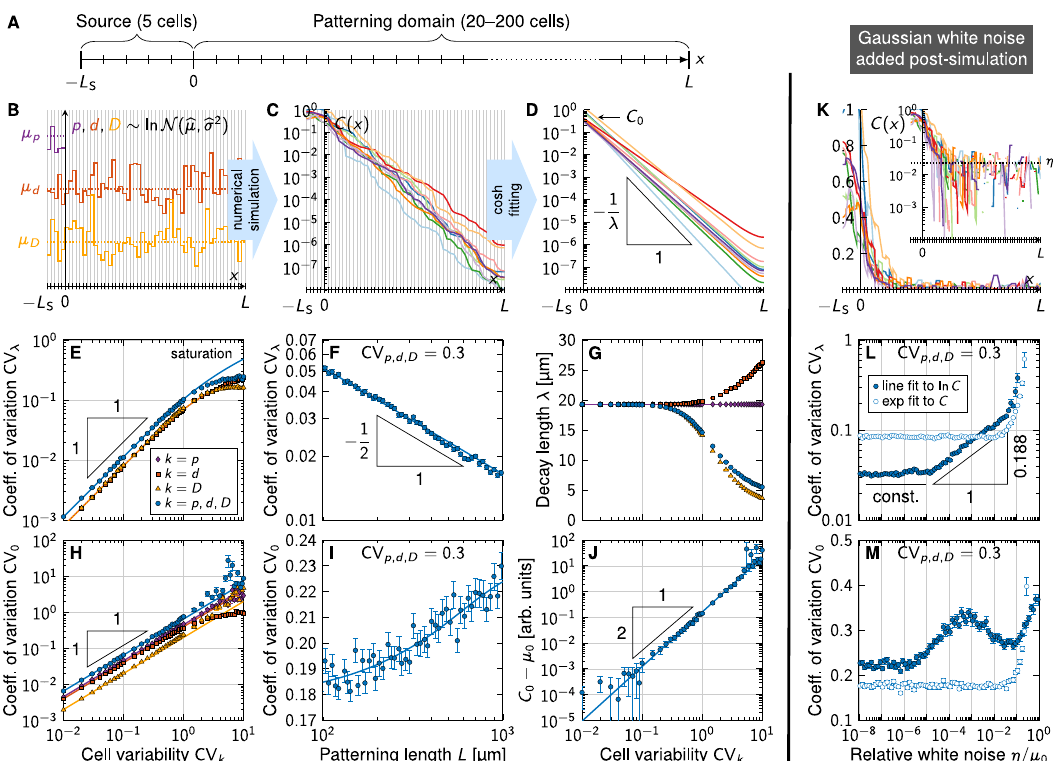
Fig. 8 Numerical model predicts gradient variability from molecular noise. A Schematic of the simulated 1D domain. B Kinetic parameters k = p , d , D (purple, red, orange) were drawn randomly and independently for each cell from log-normal distributions with speci fi ed mean μ k and coef fi cient of variation CV k . C Solving the reaction-diffusion equation repeatedly yields noisy morphogen gradients, from which the decay length λ and amplitude C 0 can be extracted by fi tting hyperbolic cosines in the patterning domain (0 ≤ x ≤ L , D ). E The resulting variability in λ grows linearly with the variability in the kinetic parameters as long as CV k ≲ 1, and saturates as CV k increases further. F The length of the domain over which noisy gradients are fi tted affects the ffiffiffi p L variability of λ according to the law of large numbers, CV λ (cid:4) 1 = . G Increasing molecular noise leads to a bias in the resulting fi tted λ . H The amplitude variability also increases linearly with CV k , but does not saturate if all three parameters have a variability exceeding one. I The variability of the fi tted amplitude moderately grows with increasing patterning domain length. J Noisy parameters also induce an overestimation of the amplitude deduced from fi tting, proportional to CV 2 N ð 0 ; η 2 Þ added to the solution in all cells limits the range over which a line can be fi tted to ln C . L Lin- k . K Gaussian white noise (cid:4) fi tting (open circles) always (also at η = 0) leads to increased decay length variability, in particular with white noise stronger than one percent of the amplitude. Log- fi tting (closed circles) is insusceptible to white noise as long as η ≲ 10 − 5 μ 0 , and increases variability according to a power law with stronger white noise. If η exceeds a few percent of the amplitude, both fi tting methods yield increased gradient length variability. M Amplitude variability is constant with lin- fi tting for η ≲ 0.1 μ 0 , whereas log- fi tting yields larger CV 0 values. L = 50 cells in all panels except ( F , I ). Data in ( E – J , L , M ) are presented as mean values ± SEM from n = 10 3 independent simulations for each data point. Source data are provided as a Source Data fi